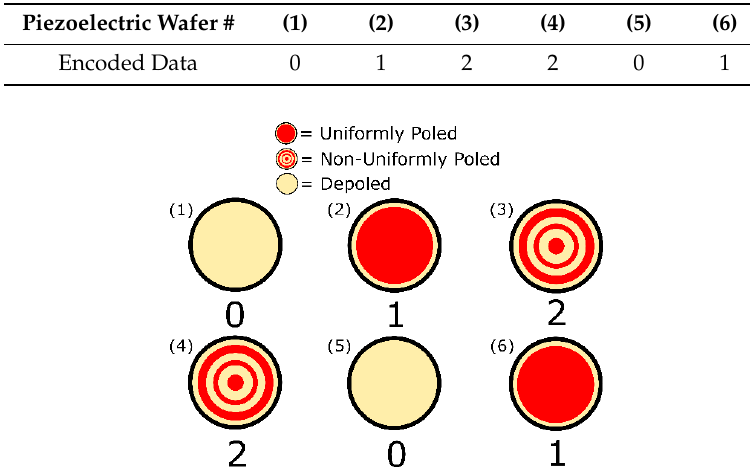
Figure 3. Polarization and arrangement of the piezoelectric circular wafers. The first row reads in ternary encoding as ‘0 1 2,’ and the second row reads as ‘2 0 1.’ The wafers in the 2-by-3 array are numbered in the upper left corner to relate this schematic to the measured conductance spectra shown in Figure 5 and the results in Table 2.